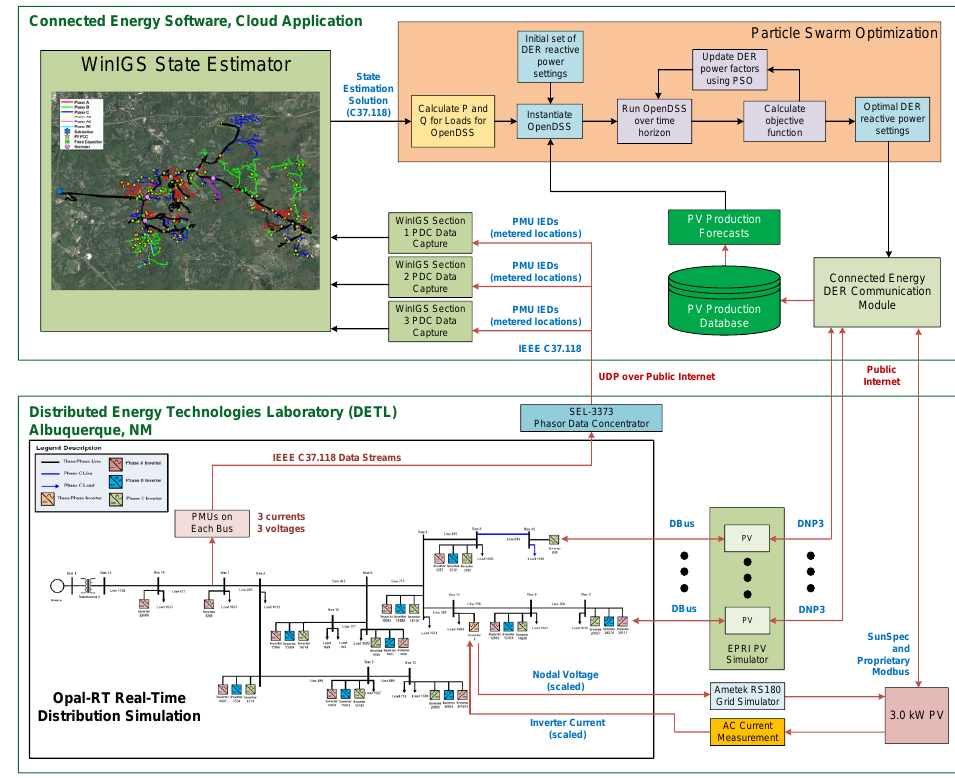
Figure 5. NG Distribution Feeder PSO PHIL Configuration with Associated Data Flows. The PHIL is composed of the WinIGS State Estimator, the PSO Optimization Engine, the RT PHIL MATLAB/Simulink simulation a physical PV inverter, the EPRI PV simulator and communication protocols that allow sending and receiving measurements information and data sets.